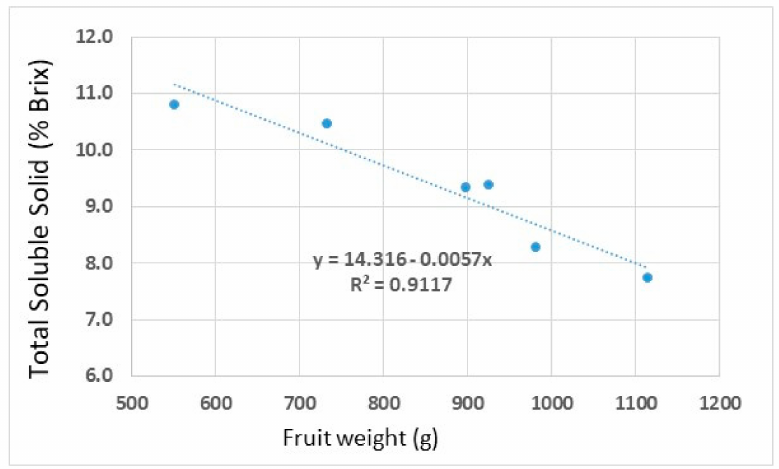
Figure 12. Relationship between total soluble solid and weight of